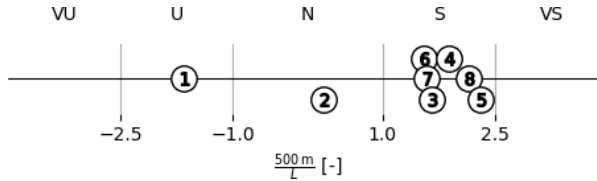
Figure 13. Obukhov lengths (plotted as 500m/ L ) found by fitting logarithmic profiles to the onshore cluster-mean wind profile shapes in Fig. 12. The stability classes are adopted from Table